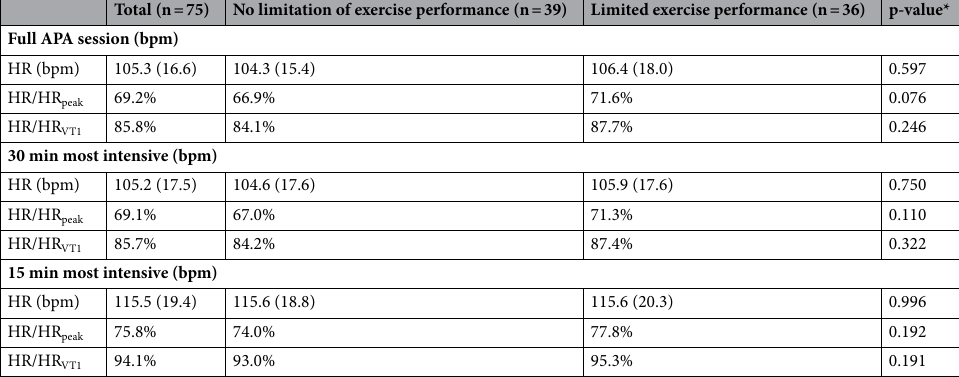
Table 2. Adapted physical activity heart rate and intensity of patient exercise capacity. Data are presented as mean (SD) for continuous variables. *We use the student T test to compare heart rate between no limitation of exercise performance and limited exercise